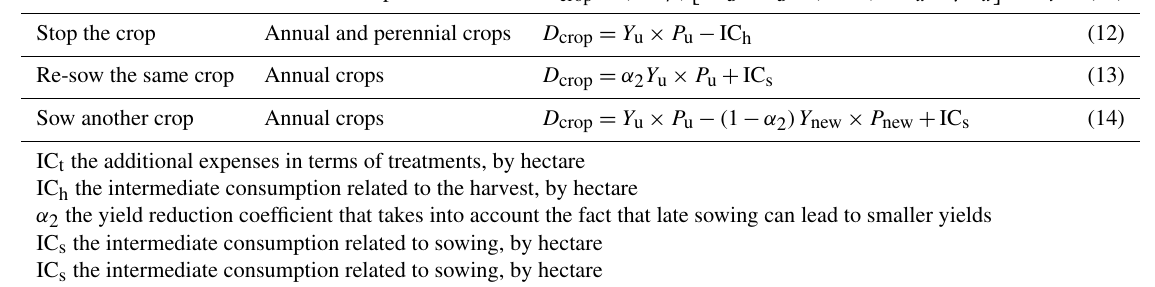
Table 7. Strategies for the continuation of the crop management sequence and associated equation. Strategy Crop concerned Equation Continue the